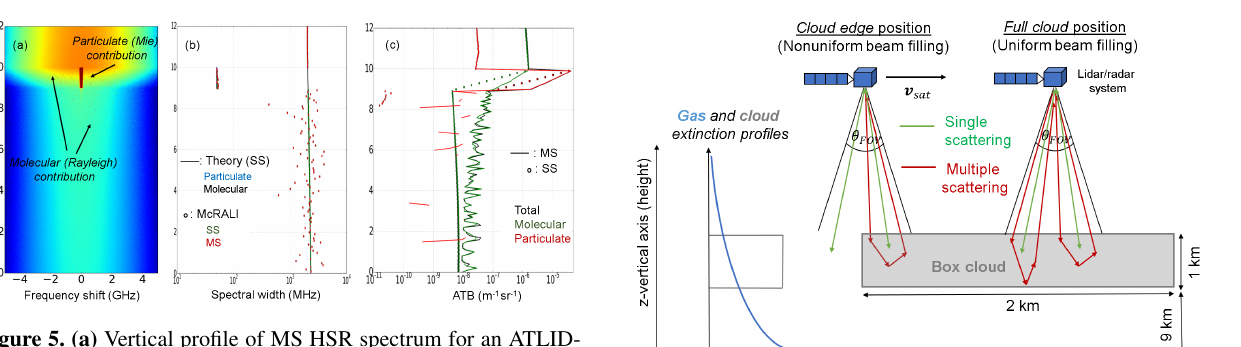
Figure 5. (a) Vertical profile of MS HSR spectrum for an ATLID- like lidar. (b) Spectral width profiles. SS and MS spectral width profiles computed by McRALI (circle) are in green and red, respec- tively. Theoretical SS molecular and SS particulate width profiles (full line) are in black and blue, respectively. (c) Vertical profiles of the MS (line) and SS (circle) backscattered coefficient (ATB). To- tal, molecular, and particulate signals are in black, green, and red, respectively. The altitude of the base of the iced homogeneous cloud layer (optical depth of 3) is 9km. Its geometrical depth is 1km.